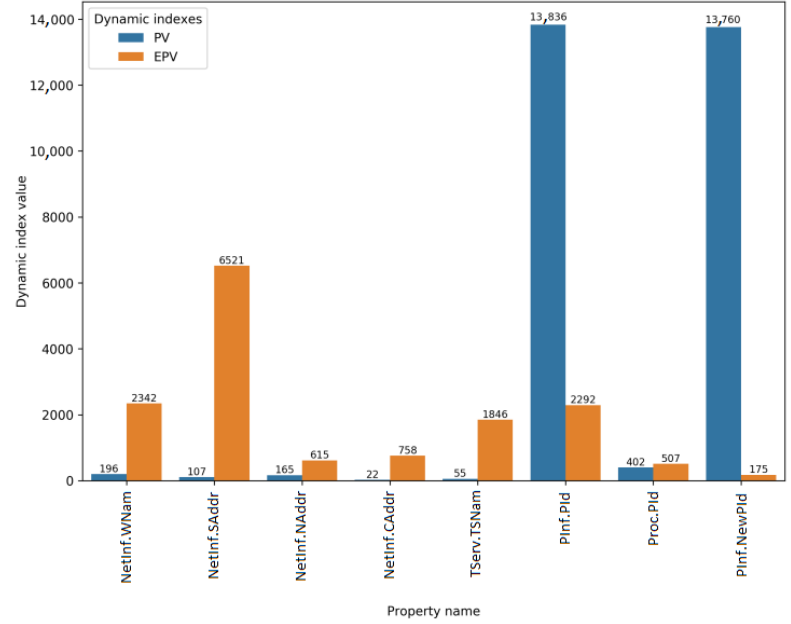
Figure 2. Dynamic indexes for the selected characteristics. In Figures 3–10 the outcome of measurements of dynamic indexes in time for the same eight properties for the observed time period is specified. PV is represented using blue and EPV using orange color.